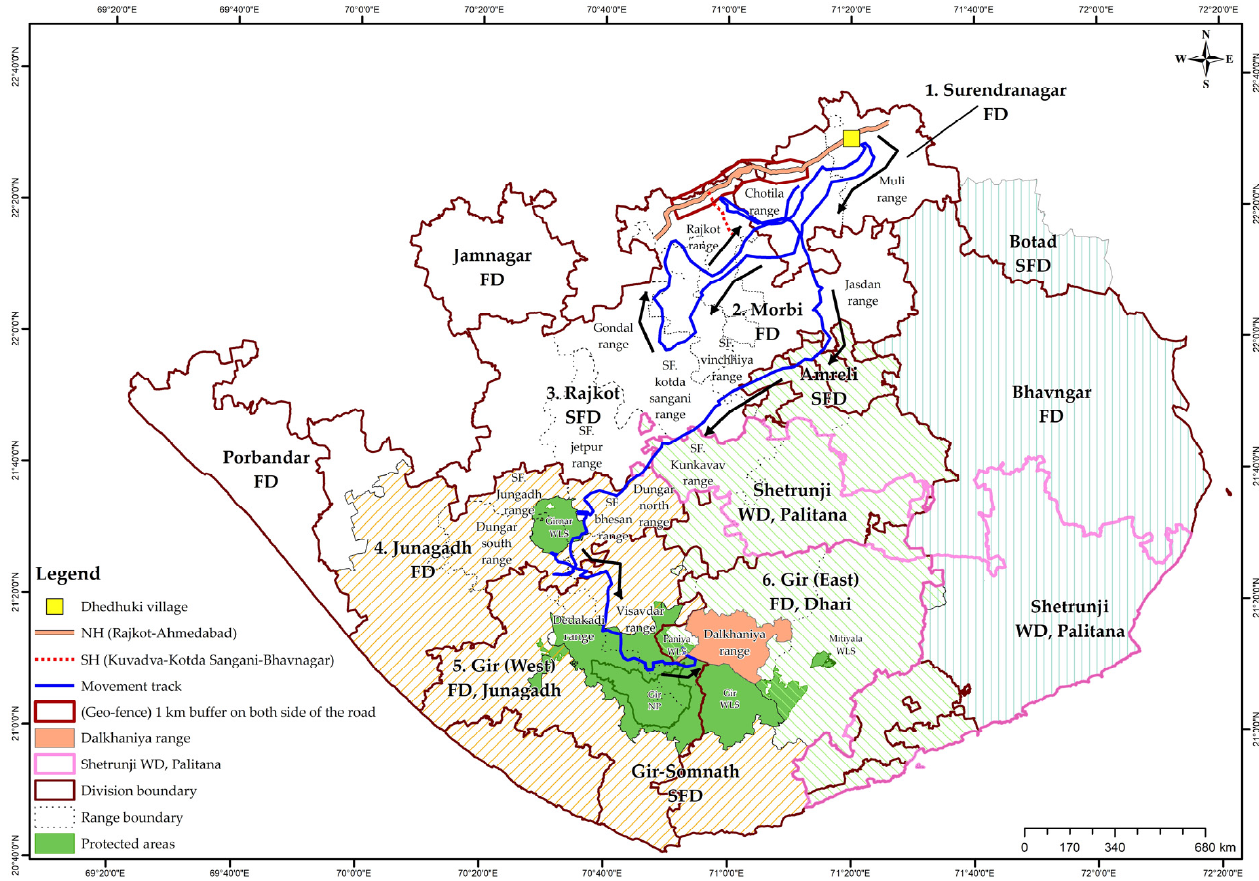
Figure 3. Dispersal paths of radio-collared sub-adult Chotila males and coalition partners monitored from December 2019 to June 2021. We traced movement paths from the early random forays after dispersal from natal territory till the time of stabilisation of range. SFD, social forestry division; FD, forest division; WD, wildlife division.